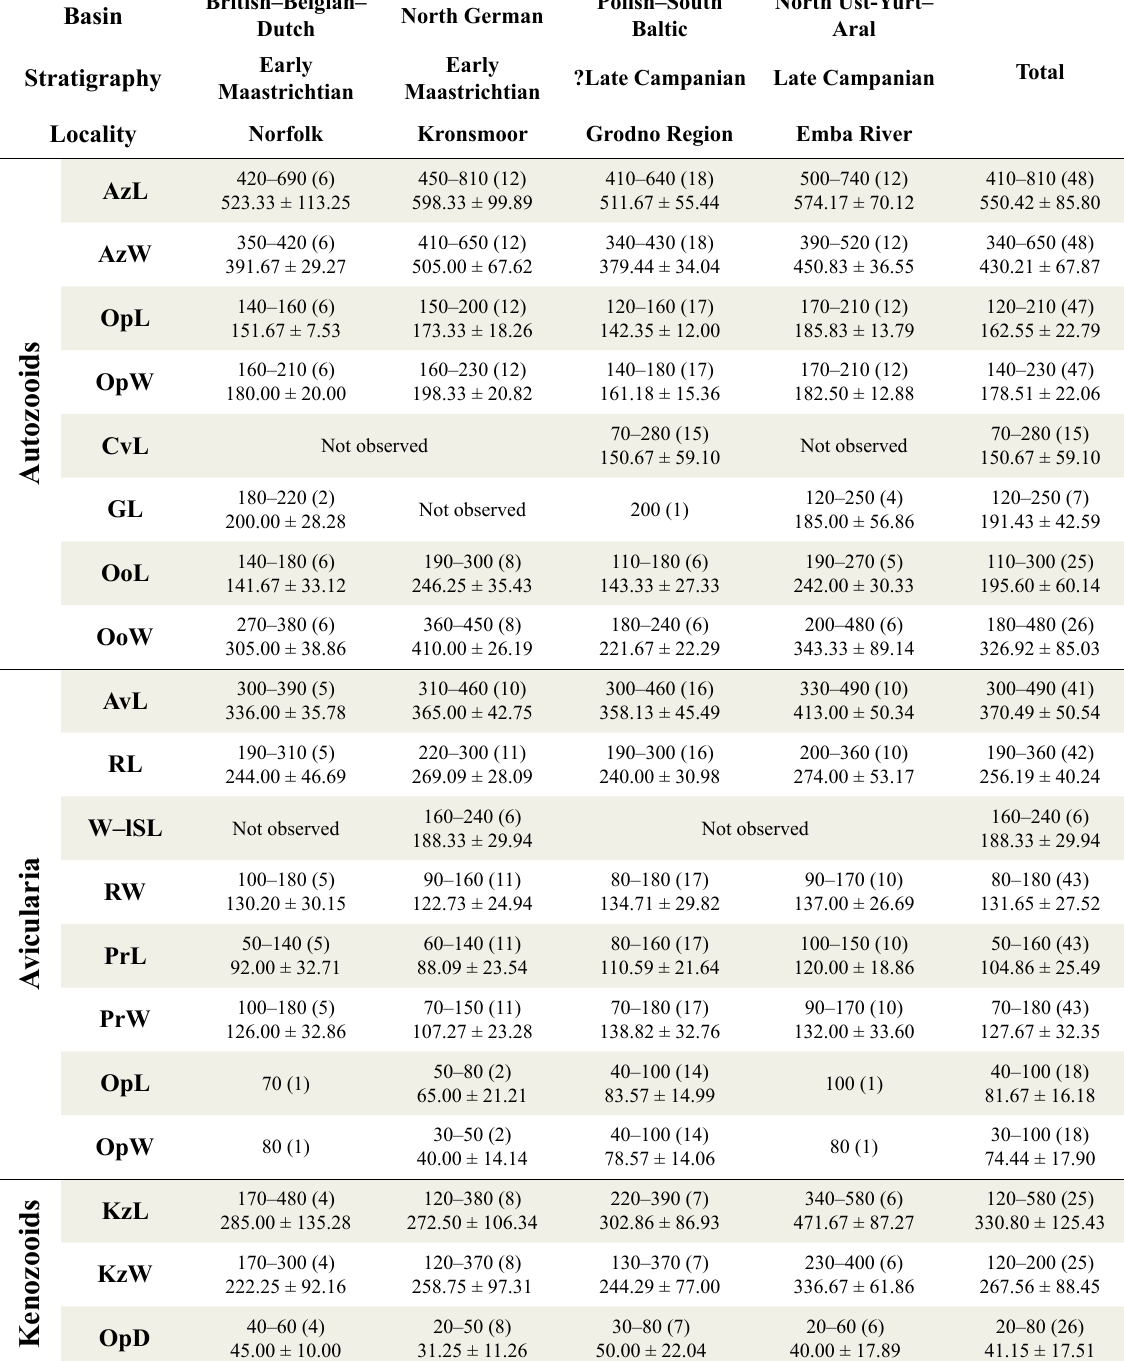
Table 7. Summary of measurements of Rhagasostoma gibbosum (Marsson, 1887). For each parameter the range is given with the number of measurements in brackets. The arithmetic mean is given ± standard deviation. All measurements in